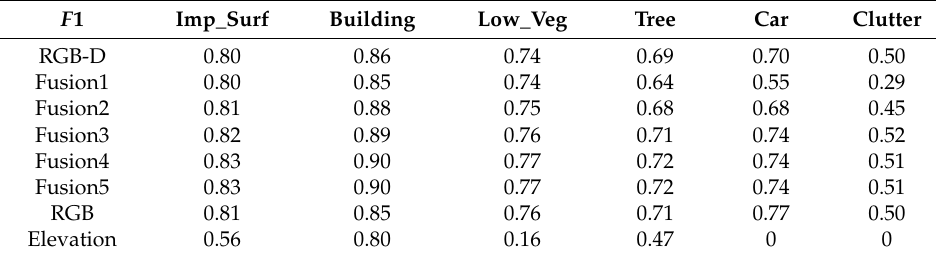
Table 6. Class-wise F 1 score of six classes for dataset